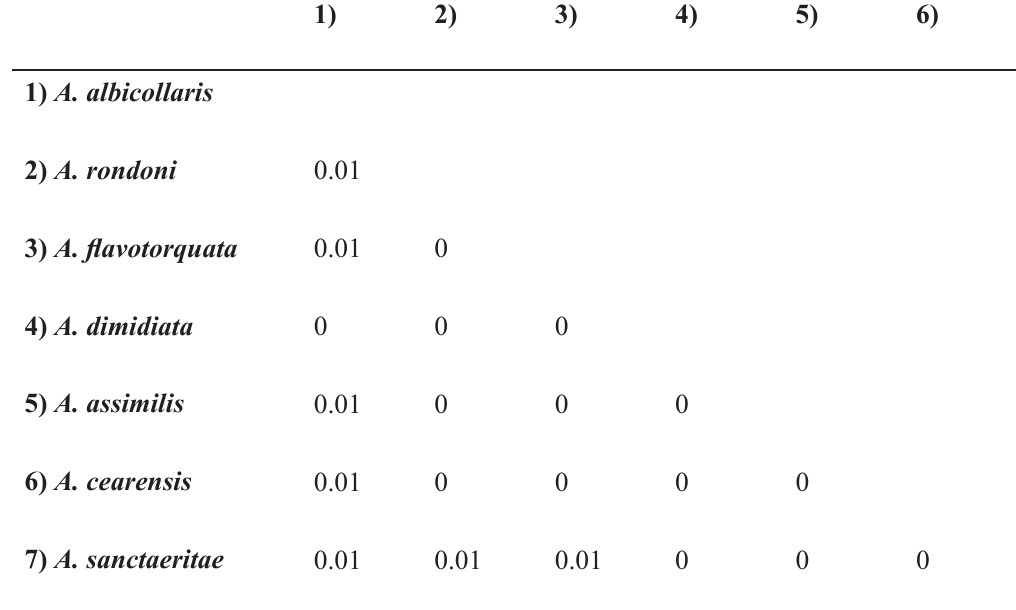
Table 3. Pairwise genetic distances for the CMOS gene among sequences of Apostolepis Cope, 1862